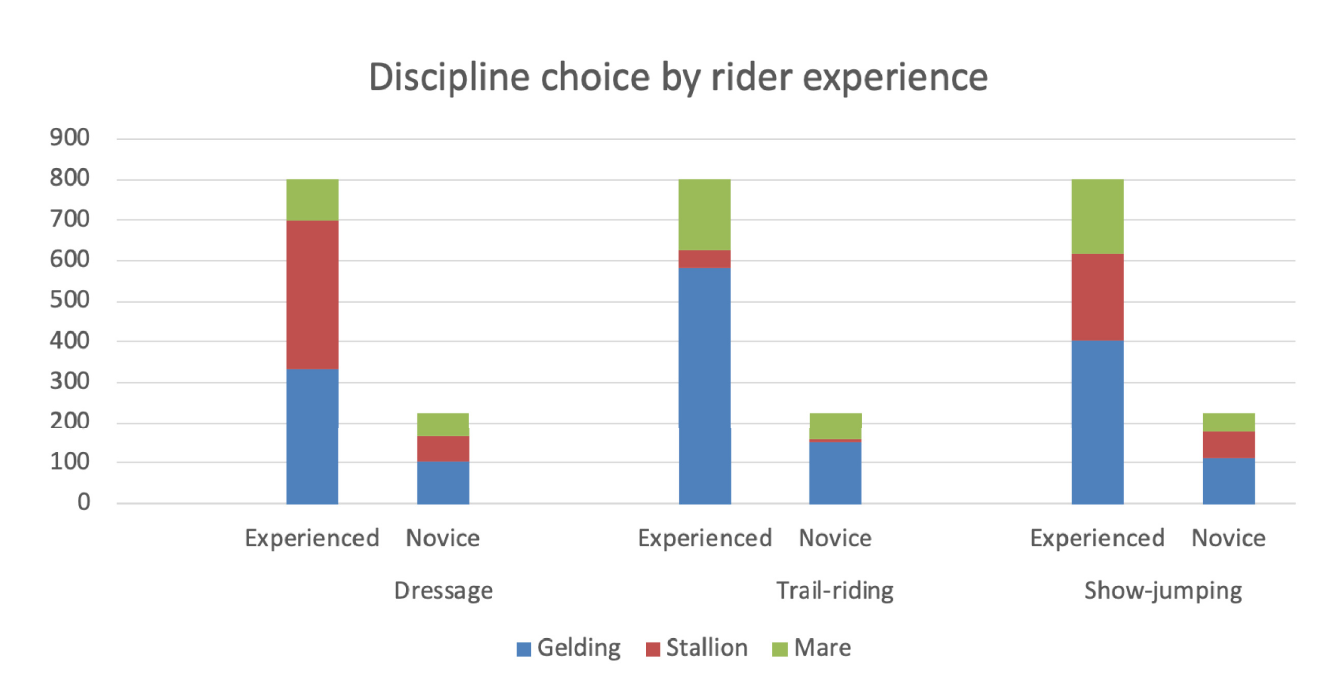
Fig 6. Respondents (n = 1230) were asked which horse they would expect to see in Dressage and show-jumping and which horse they would choose to ride on a trail ride. The figure shows discipline choice by rider experience